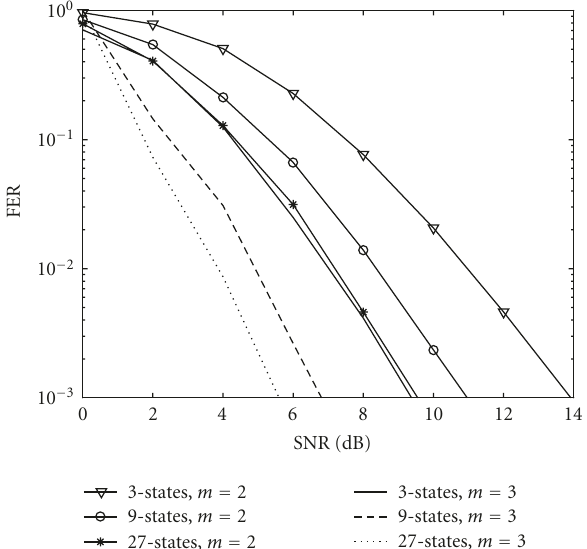
Figure 4: Performance comparison of STCCs for 4-PSK obtained with di ff erent encoder structures for n = 3, m = 2, and 4,8, and 64